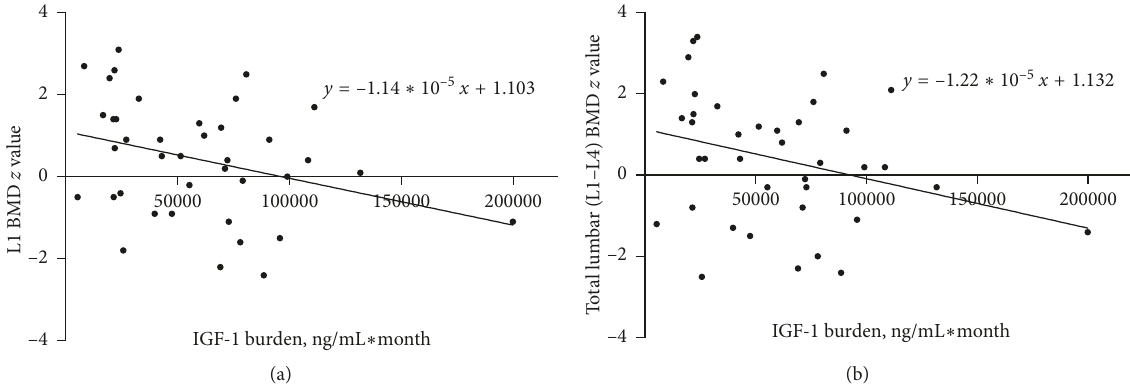
Figure 1: Correlation plot showing the correlations between IGF-1 burden and BMD Z scores: (a) a negative correlation was found between IGF-1 burden and the L1 BMD Z score ( r � − 0.326, p � 0 . 042). (b) A negative correlation was found between IGF-1 burden and the total lumbar (L1–L4) BMD Z score ( r �− 0.319, p � 0 . 048).